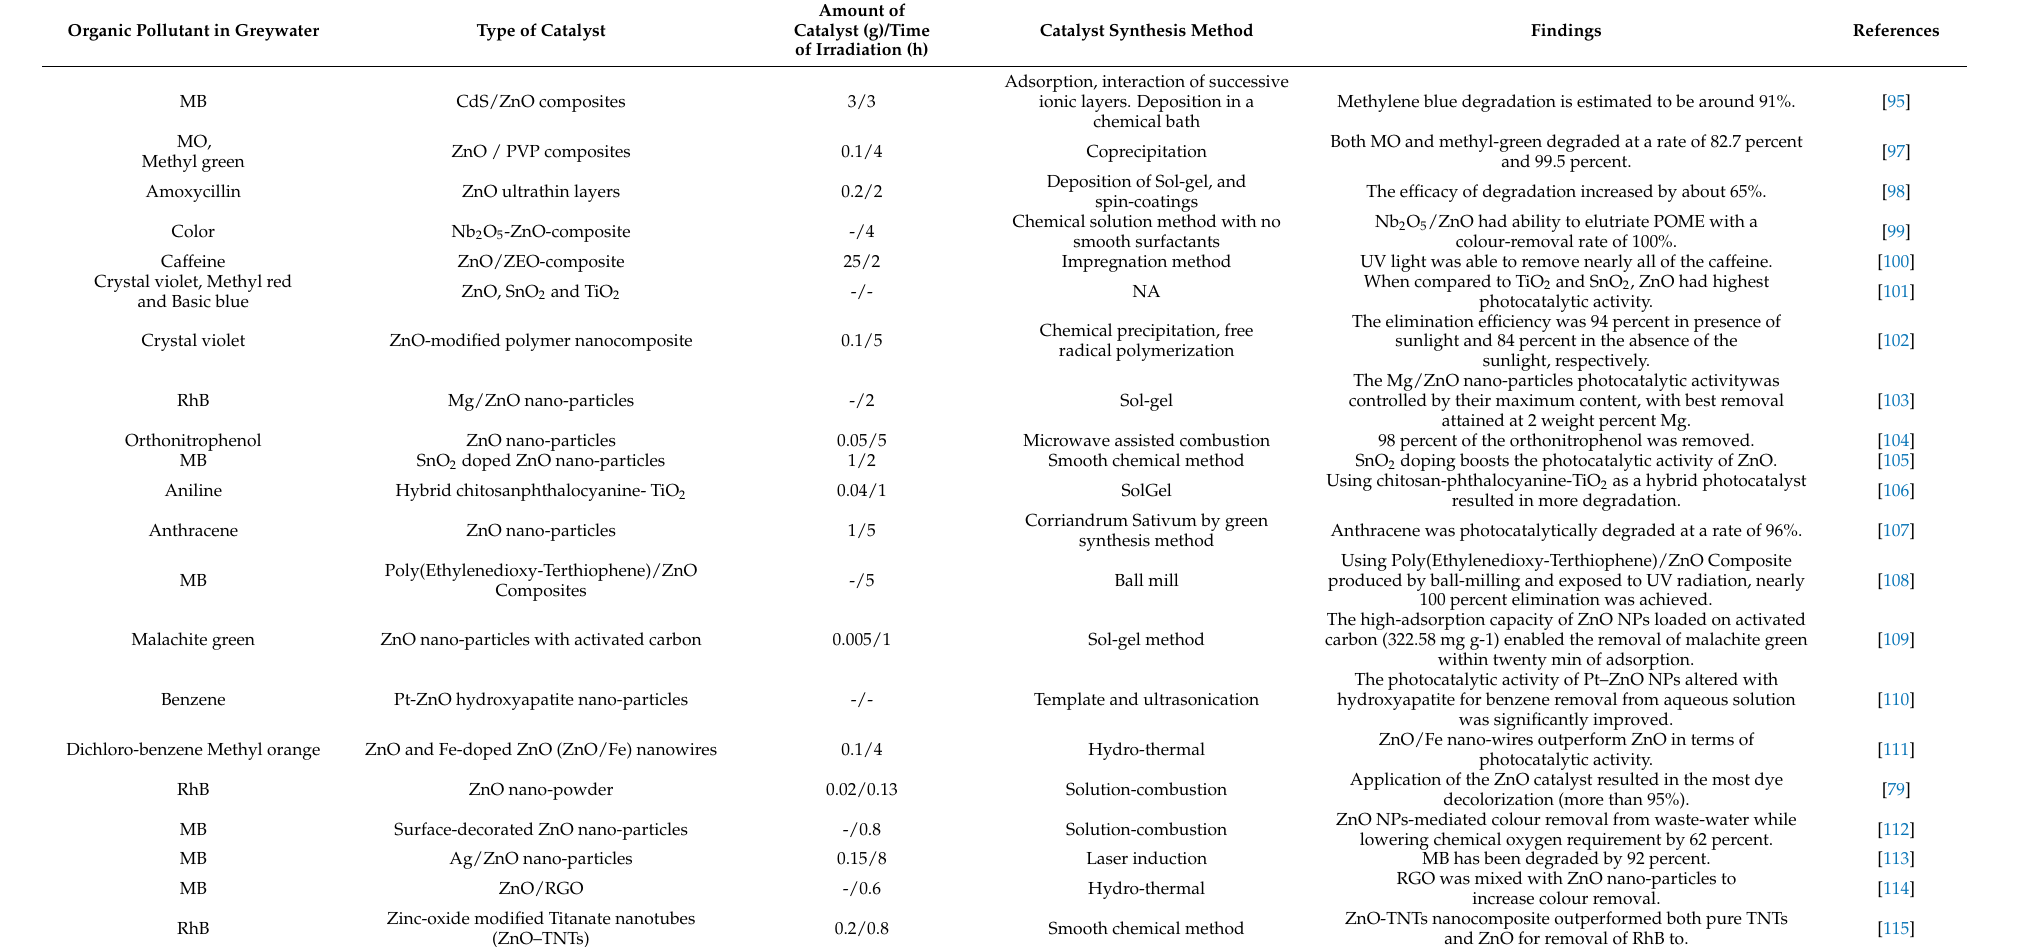
Table 7. ZnO-supported photocatalyst matrix is used to photocatalytically degrade organic pollutants in